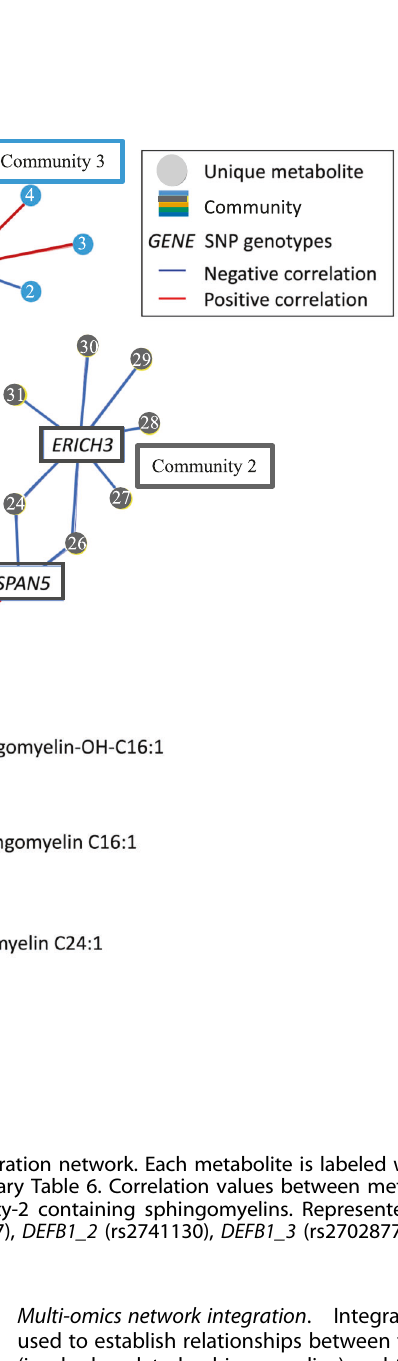
“ multi-omics models ” feature set from these subjects, accuracies changed to 77.5% ( p = 0.0067; AUC: 0.86) and 73.2% ( p = 0.085; AUC: 0.74) (Table 2B) — representing an improvement of 2.2% for penalized regression. Top predictor variables . The top predictors were calculated using the models trained on escitalopram, citalopram, or escitalopram + placebo-treated patients, to maximize the number of patients in the variable importance calculations. The top predictors varied by algorithm and feature set, but hydroxylated sphingomyelins, glycerophospholipids, clinical/sociodemographic features, and acylcarnitines, and were all represented (Fig. 2). Although SNPs were not among top predictors in both approaches, augmenting the models with SNPs increased the predictive importance of clinical/sociodemographic features (ethnicity, baseline depression, and change in energy). In addition, in the XGBoost models, change in QIDS-C score was a top predictor of treatment outcomes and inclusion of SNPs increased the predictive importance of hydroxylated sphingomyelins.